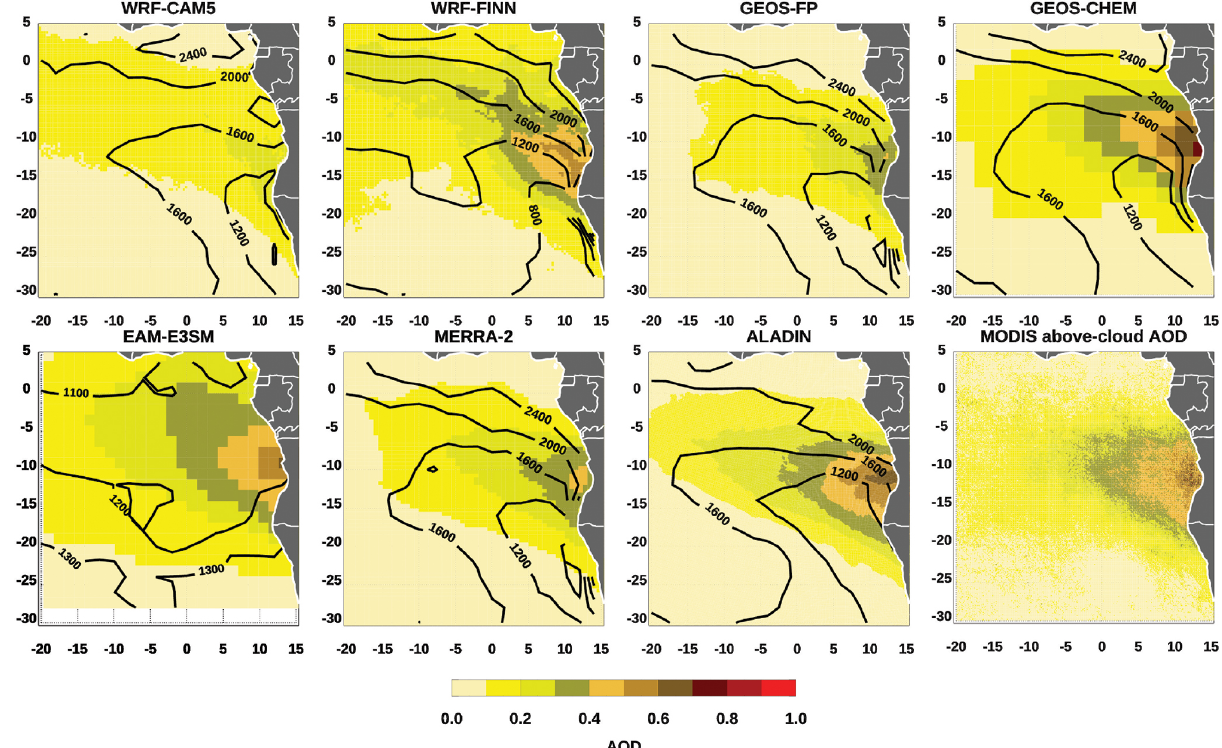
Figure 8. Monthly mean modeled AOD in the FT at 12:00UTC and MODIS (Terra and Aqua) ACAOD for September 2016. Contours are PBL heights in